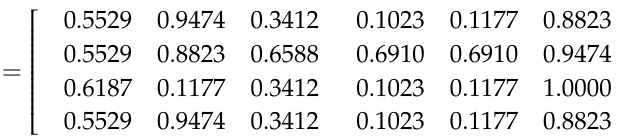
Table 3. Weight of the evaluation indices.